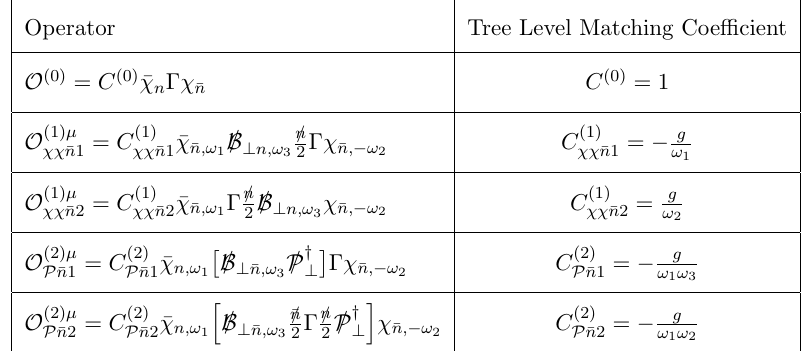
( (cid:21) 2 ) at LL, along O